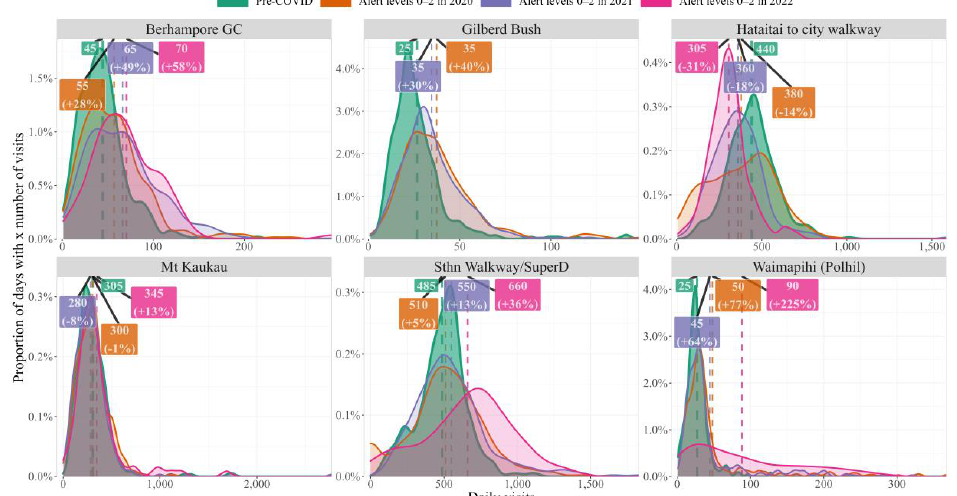
Figure 6. The distribution of daily visits during low Alert Levels (0–2) in 2020 (orange), 2021 (purple), and 2022 (pink) compared to the pre-COVID-19 (2019) periods. The graphs show the proportion of days (y-axis) with a number of daily visitors (x-axis), and thus show how consistent the number of visits is. The mean daily visitors are also marked with a dashed line and label with this compared to 2019. All values have been corrected for mean monthly and weekend/weekday